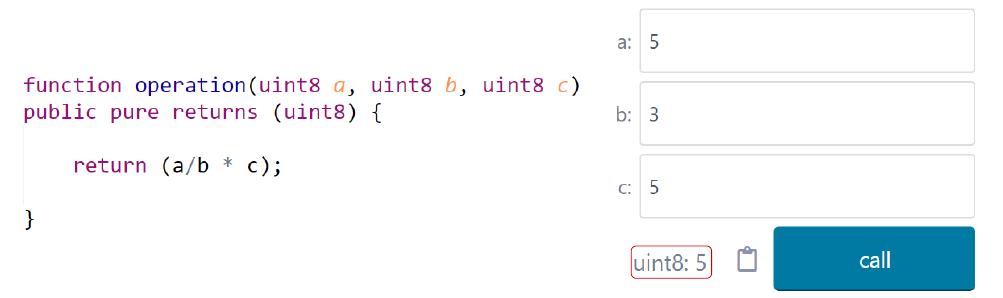
Figure 4. Arithmetic operation result in